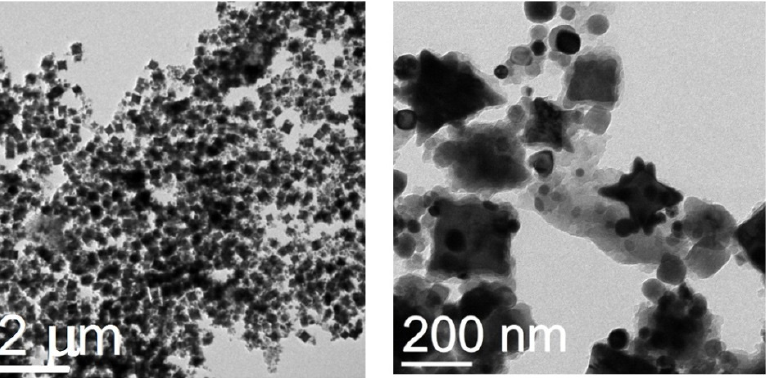
Figure 4. TEM images of the two steps synthesized Fe 3 O 4 @C@C NPs with different magnification.